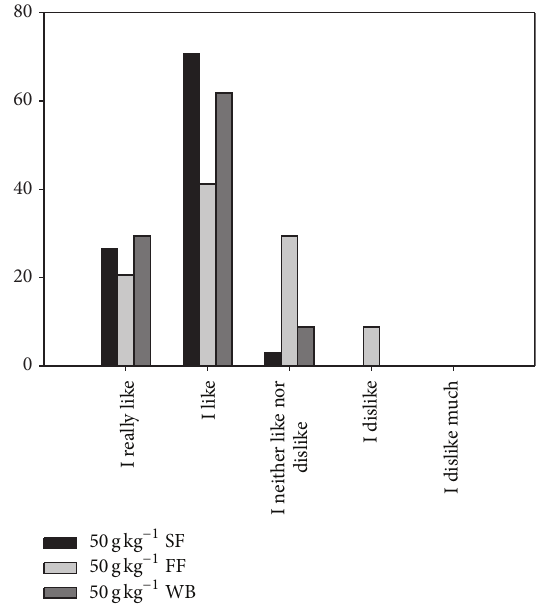
Figure 1: Results of sensorial analysis of selected bread. SF: soybean flour, FF: flaxseed flour, and WB: wheat